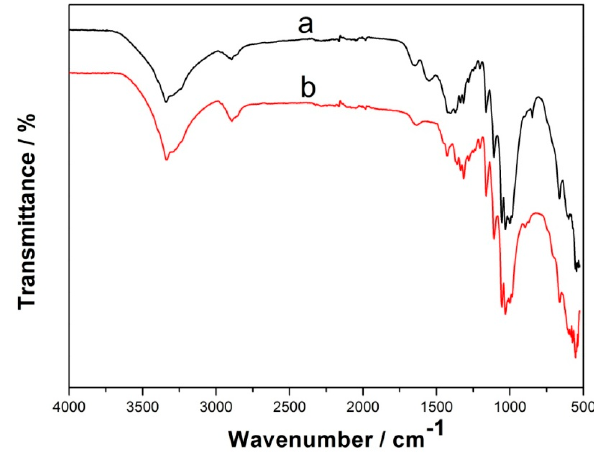
Figure 1. Fourier transform infrared (FT-IR) spectra of: BC ( a ); and PdBC ( b ).